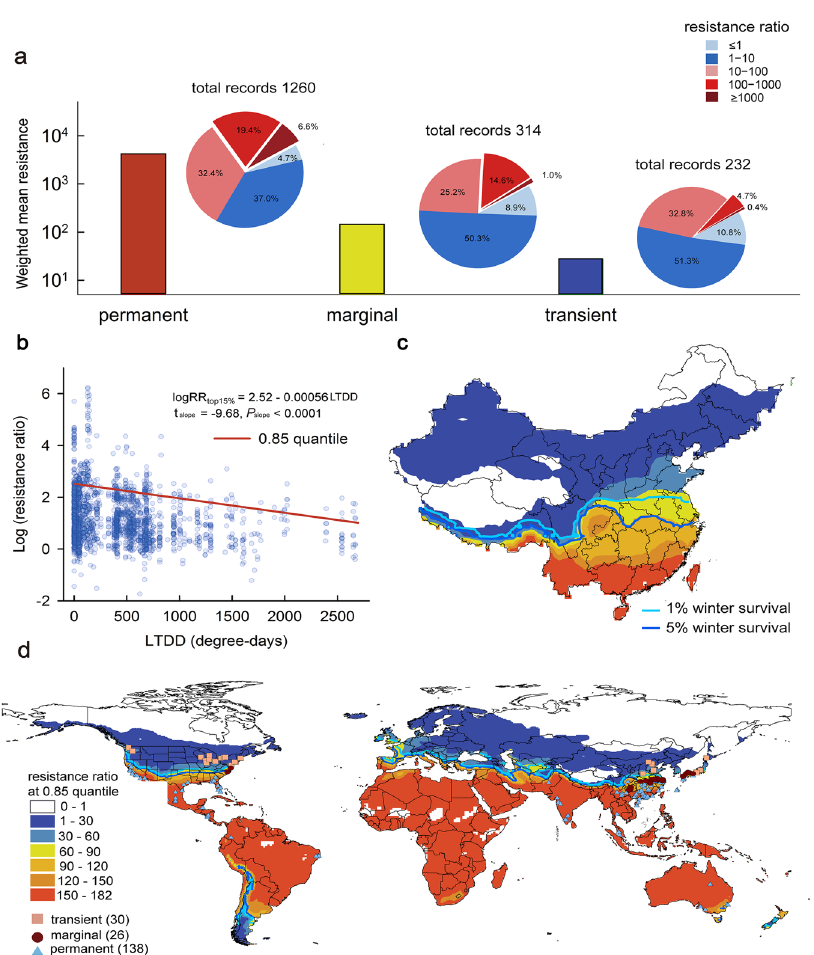
Fig. 4 Pesticide resistance of the diamondback moth. a Weighted mean resistance (ratio) and relative frequencies of different resistance levels (percentages in the pie charts) in the permanent, marginal and transient sites. b Relationship between the top 15% (0.85 quantile) resistance ratio (log 10 transformed) and low-temperature degree-days (LTDD) ( n = 1806). The signi fi cance of the slope ( P value) in the quantile regression was tested by two- sided t -test. c Predicted distribution of the top 15% pesticide resistances in China. d Global distribution of sampling sites for pesticide resistance tests used in meta-analysis and the predicted geographic distribution of the top 15% pesticide resistance. Source data are provided as a Source data fi